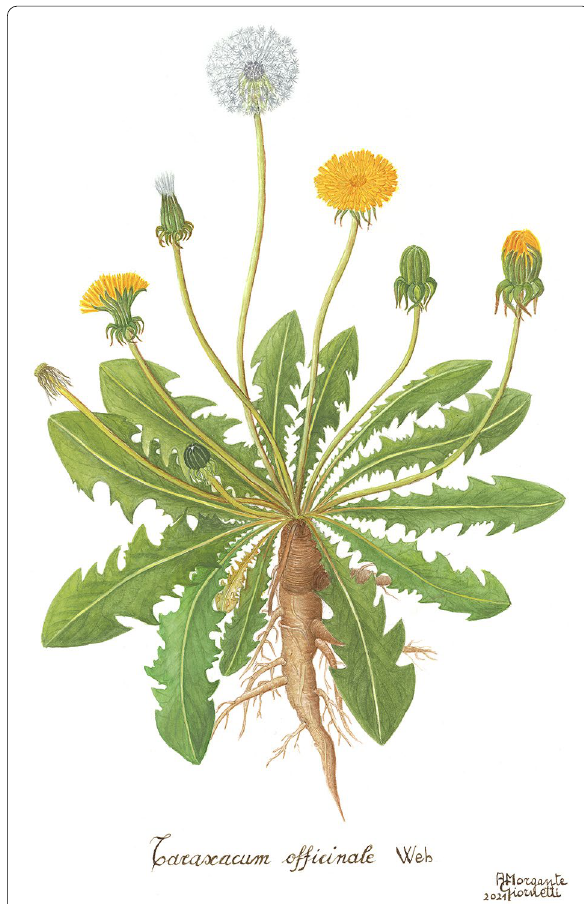
Fig. 1 Taraxacum officinale . A botanical illustration of the plant (" Taraxacum officinale Web" by Adriana Morgante